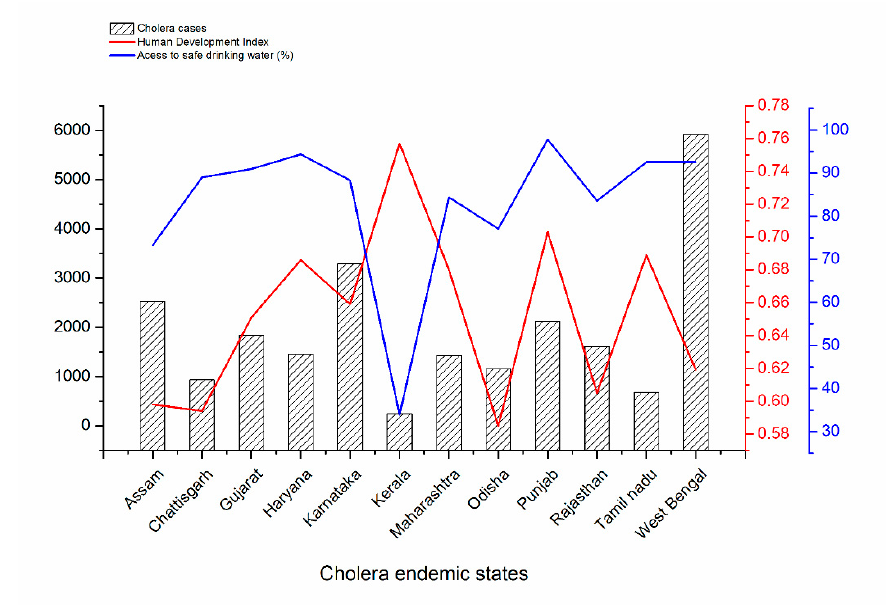
Figure 2. Cumulative cholera case (2010–2015) in 12 endemic states of India plotted against their respective Human Development Index and % of population access to safe drinking water.